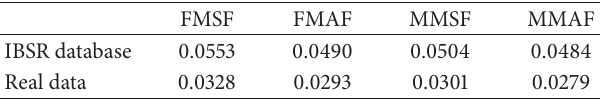
Table 3: Comparison of the mean values of SSD for various databases.